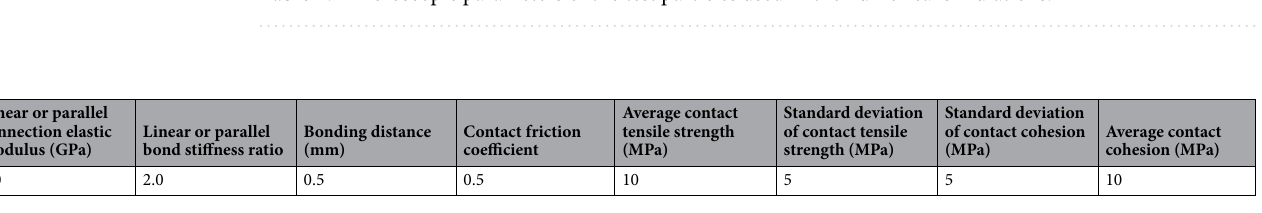
Table 2. Meso-parameters of the parallel bonding model in the numerical